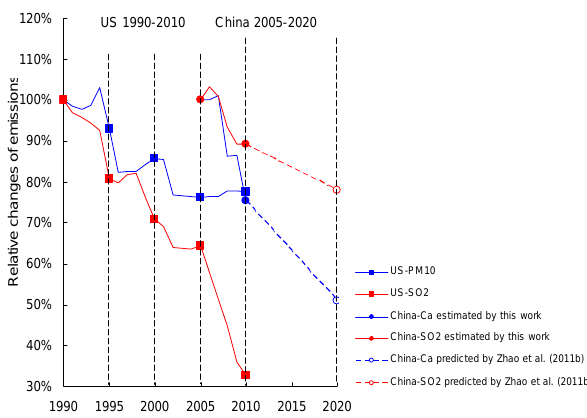
Fig. 7. Relative changes of SO 2 and PM 10 /Ca emissions for USA 1990-2010 and China